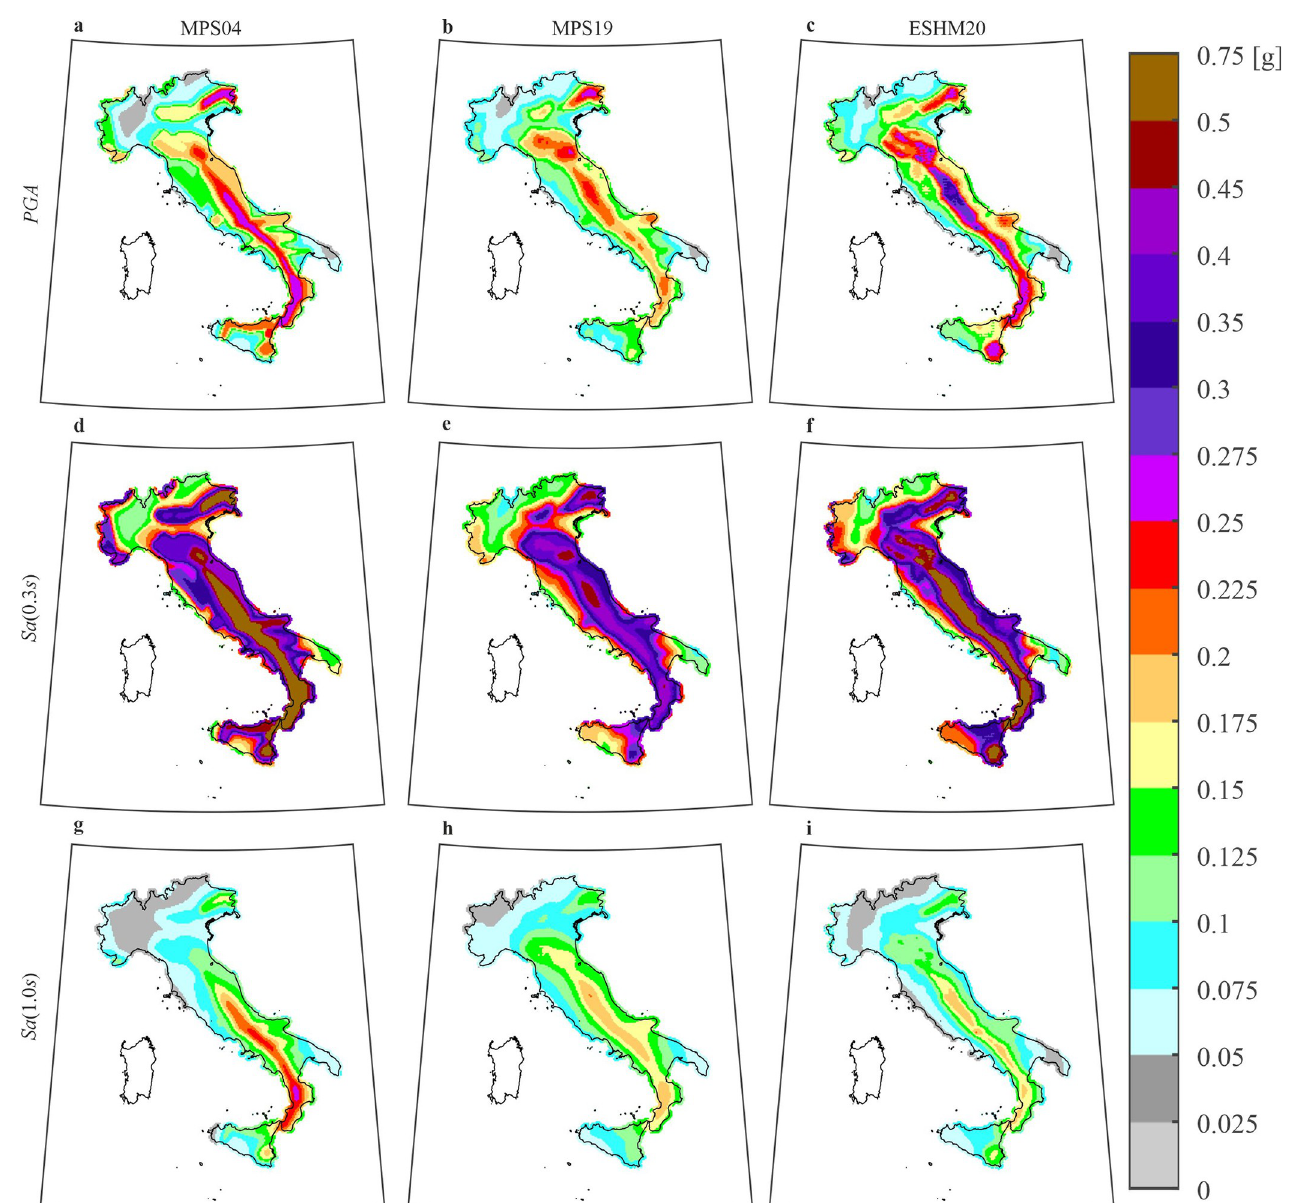
Fig 1. T r = 475 yr hazard maps on rock according to three authoritative models for three intensity measures. The panels in the same columns refer to the same model: (a), (d), (g) are from MPS04; (b), (e), (h) are from MPS19; (c), (f), (i) are from ESHM20. The panels in the same row refer to the same IM : (a), (b), (c) are PGA ; (d), (e), (f) are Sa ( 0.3 s );(g), (h), (i) are Sa ( 1.0 s ). The maps were generated using the Matlab mapping toolbox version 4.10 (https://it.mathworks.